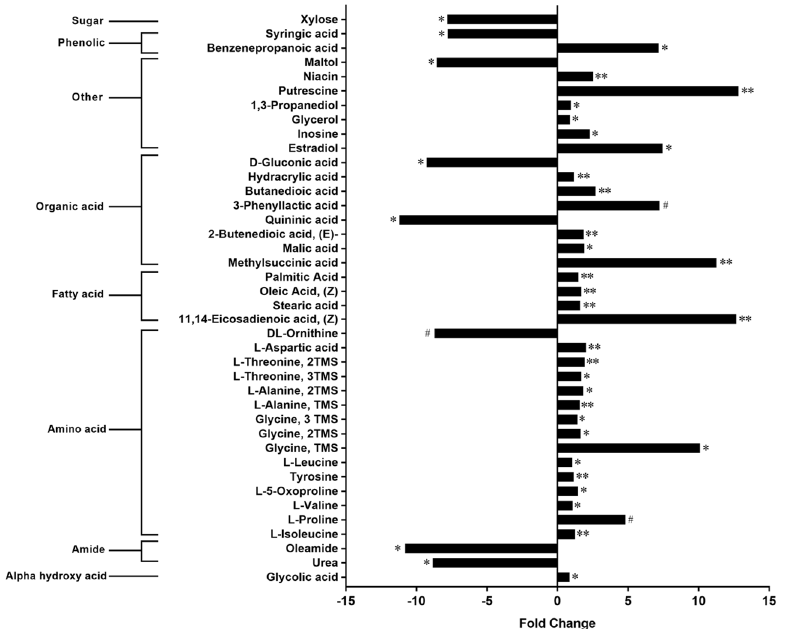
Figure 2. Cecal metabolite profiles in dextran sulfate sodium (DSS)-induced colitis mice receiving water with or without alpha-ketoglutarate. Mean ± SEM, n = 7–8 per group, #: p < 0.10, *: p < 0.05, **: p < 0.01.